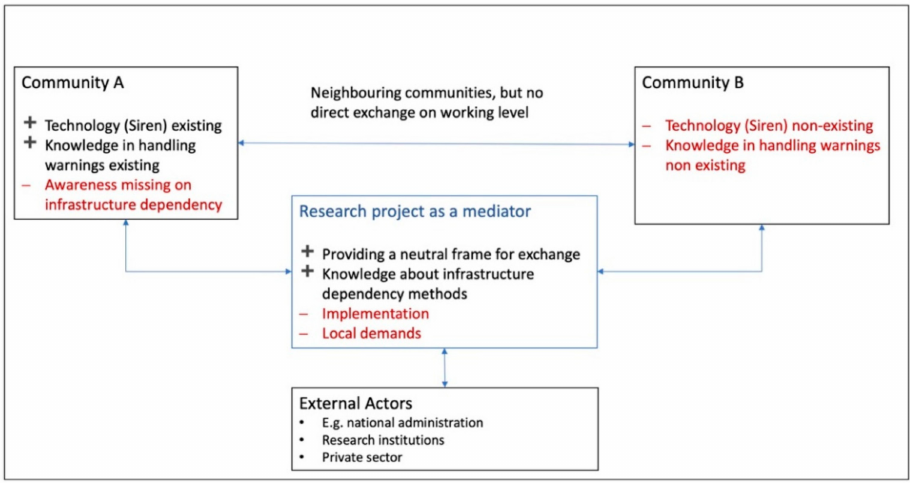
Figure 4. Schematic example of a knowledge exchange demand between neighbouring